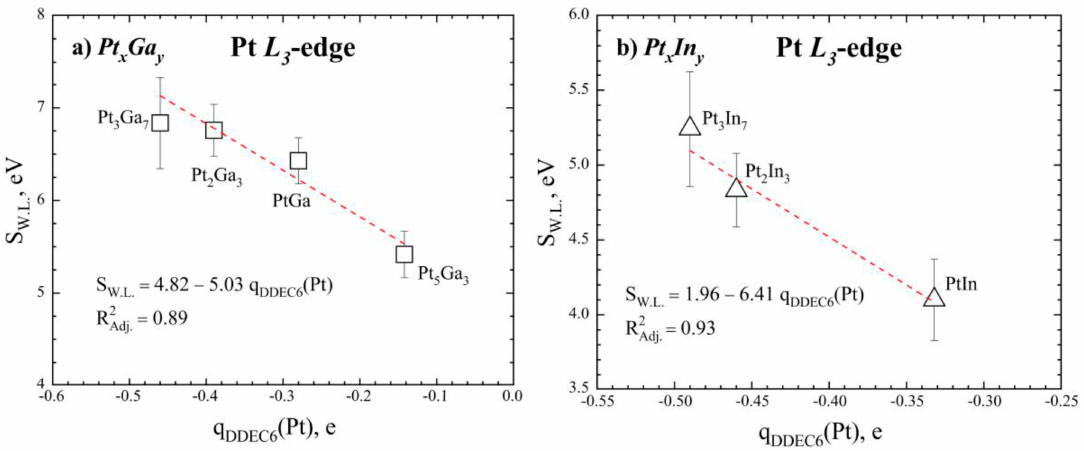
Figure 8. The correlation between the white line area (S W.L. ) of Pt L 3 -edge spectra and the Pt DDEC6 charge. ( a ) Pt x Ga y and ( b ) Pt x In y groups.